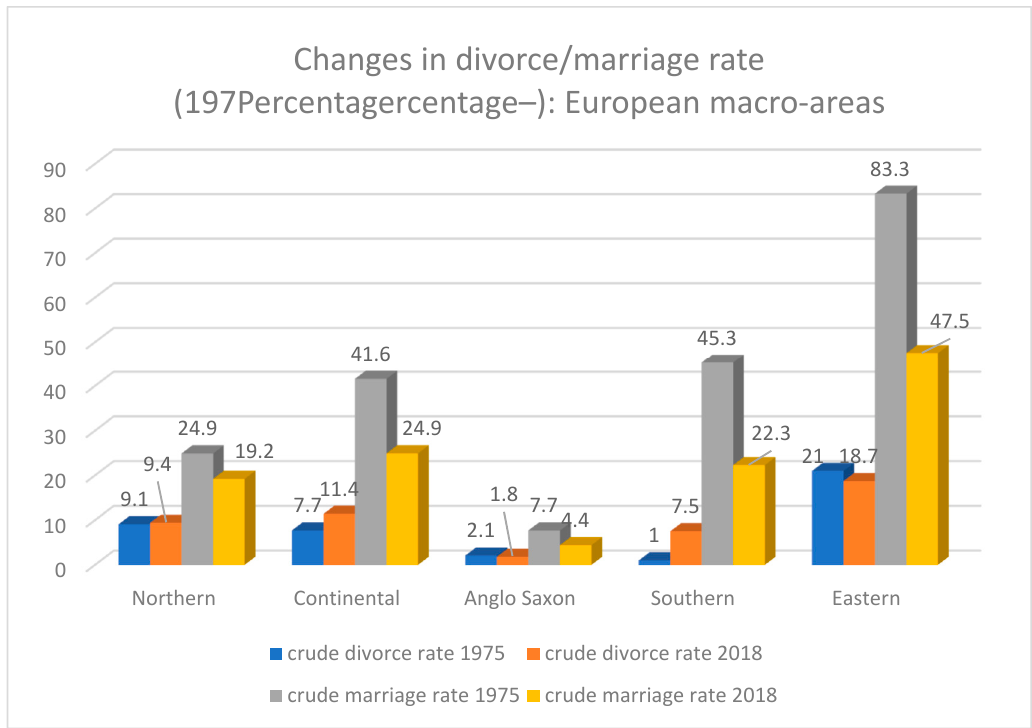
Figure 2. Source: our elaboration on Eurostat data. Northern: Denmark, Finland, Norway, Sweden (Iceland is not included for missing data on divorces from 2012). Continental: Austria, Belgium, France, Germany, Luxembourg, Netherlands. Anglo Saxon: United Kingdom (in Ireland the divorce has been introduced in 1996). Southern: Cyprus, Greece, Italy, Portugal, (in Spain the divorce law the law was introduced in 1931, then abolished and reintroduced in 1981). Eastern: Bulgaria. Czech Republic, Estonia, Hungary, Latvia, Lithuania, Poland, Slovak, Slovenia.